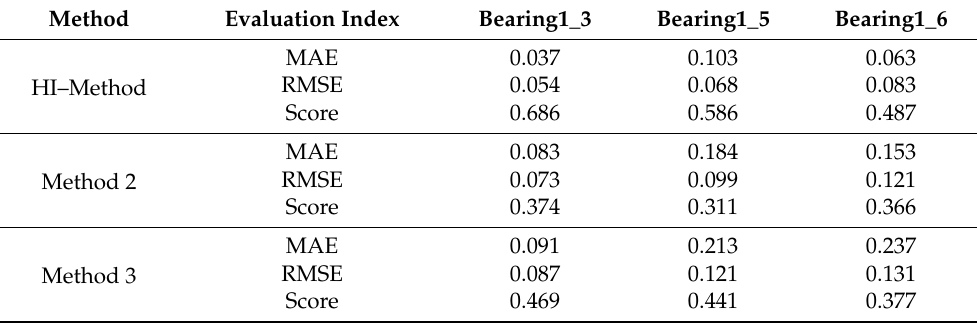
Table 5. Performance comparison of bearing RUL prediction